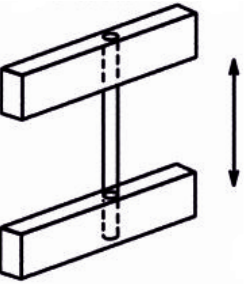
Figure 2. Illustration of the “H”-type specimen. A glass fiber was fixed in two rubber plates during sample preparation. Arrow shows direction of the sample elongation.